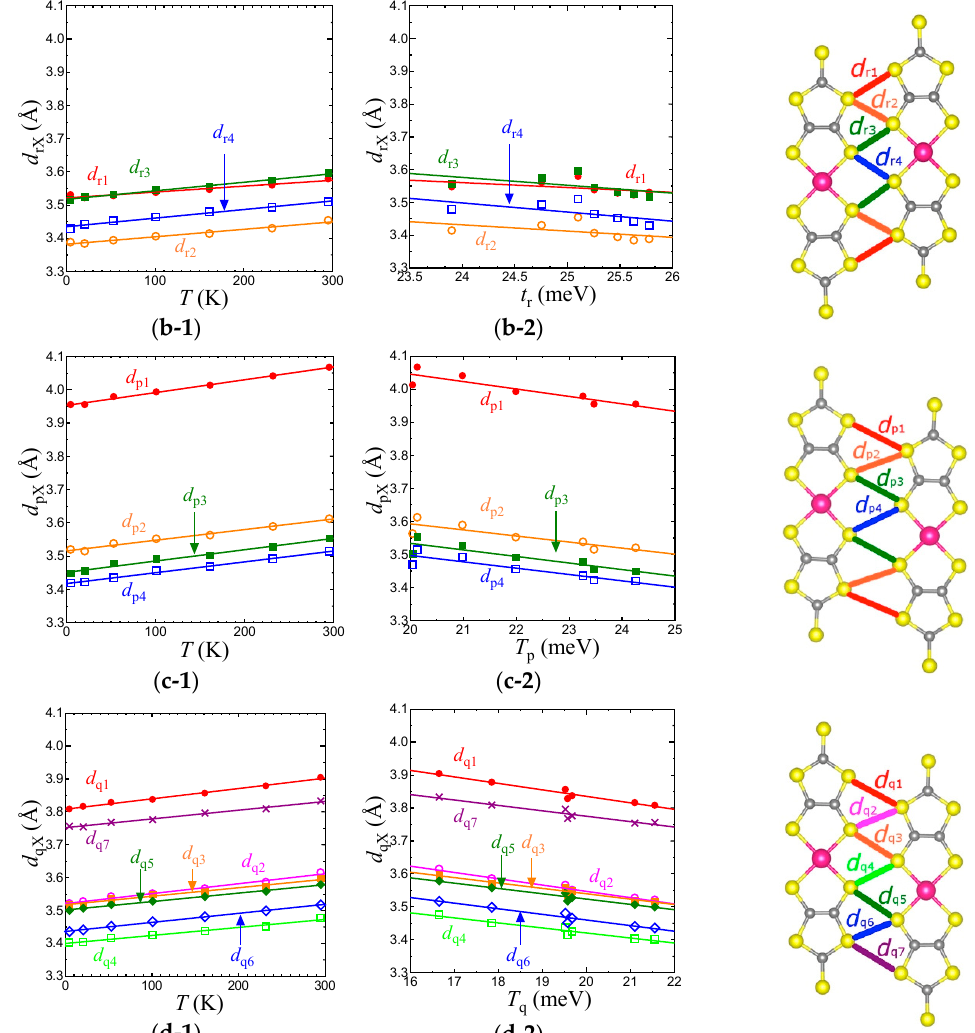
Figure 7. Temperature dependence of intermolecular S ⋯ S distances associated with T B ( a-1 ), T r ( b-1 ), T p ( c-1 ), and T q ( d-1 ) in the EtMe 3 Sb salt. Relationships between the S ⋯ S distances and intermolecular transfer integrals, T B ( a-2 ), T r ( b-2 ), T p ( c-2 ), and T q ( d-2 ) in the EtMe 3 Sb salt. With lowering temperature, all intermolecular S ⋯ S distances were reduced linearly (Figure 7).